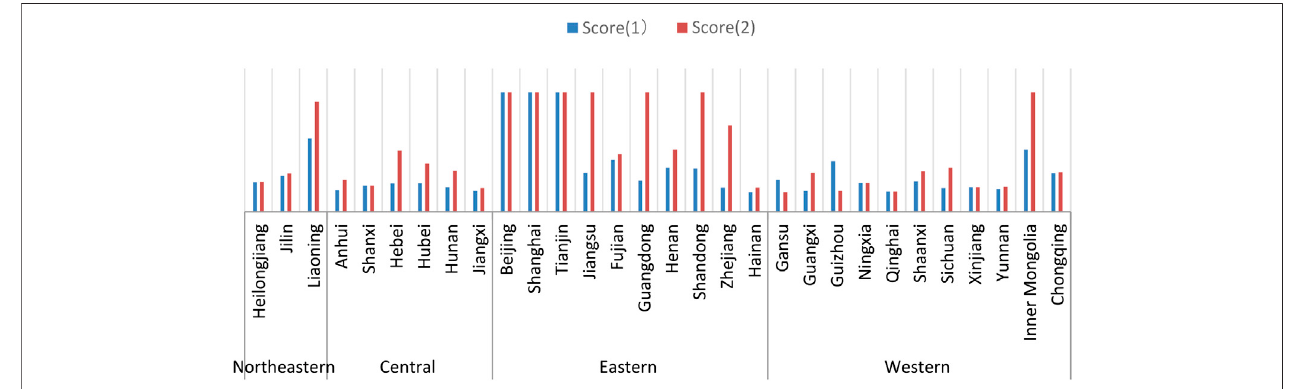
FIGURE 3 | Total ef fi ciency score of each